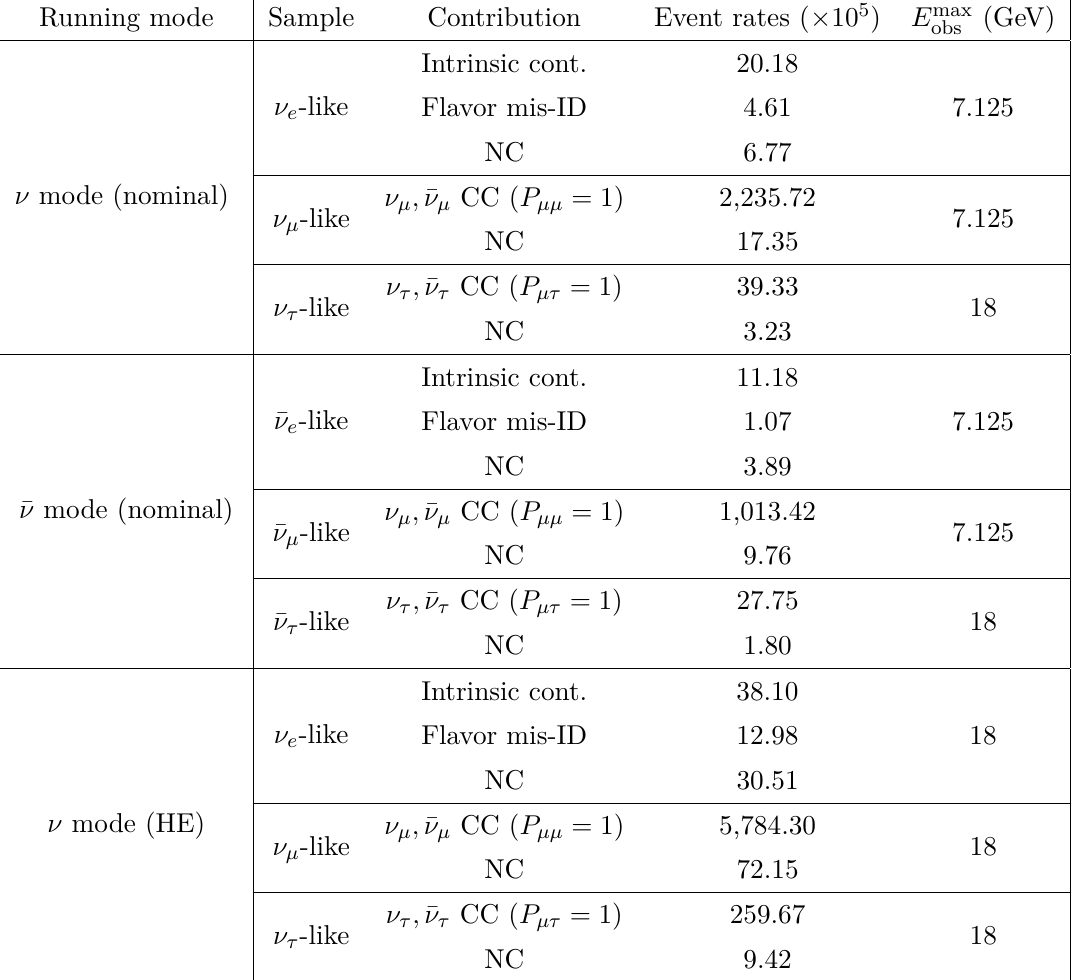
Table 4 . Expected total number of events for the different contributions to the event samples simulated in our analysis, for the nominal and high-energy (HE) beam configurations. Note that for the nominal beam we consider 3.5 years of data taking in neutrino and in antineutrino modes, while for the HE configuration we only consider 3.5 years in neutrino mode, see table 2. The background contributions are separated into intrinsic beam contamination (intrinsic cont.), flavor mis-identification (flavor mis-ID) and neutral-current (NC) backgrounds, adding the contributions from neutrinos and antineutrinos. We also provide the expected number of charged-current (CC) ν µ and ¯ ν µ events for P µµ = 1 , as well as the ν τ and ¯ ν τ CC events for P µτ = 1 . The latter can be trivially rescaled to a given value of α , see eqs. (2.11) and (2.12). In all cases, detection efficiencies and smearing effects have already been accounted for. Finally, the last column indicates the maximum energy considered for each of the samples (corresponding to observed energy). See text for additional